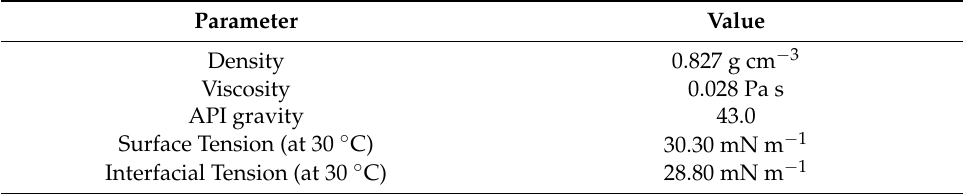
Table 1. Physical properties of Tapis crude oil.